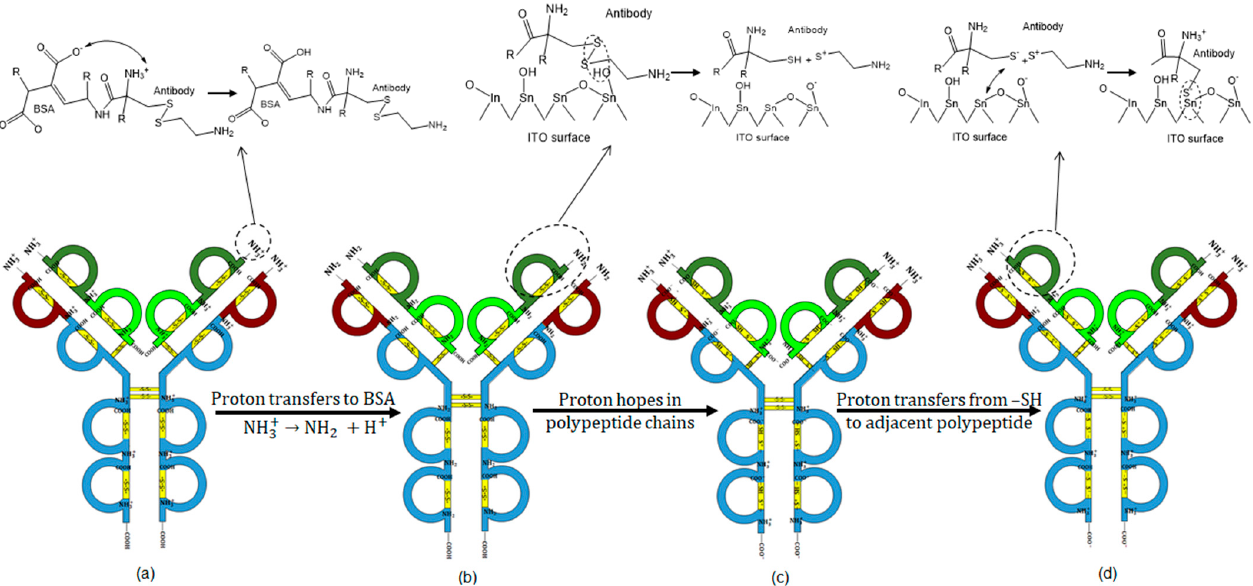
Figure 8. The charge transfer scheme in polypeptide chains in antibodies. ( a ) IgG antibodies with 16 disulfide bonds, the carboxylic groups at the C-terminal end, and the α -amino groups (NH + ) at the N-terminal end of the polypeptide. 3 ( b ) Due to conjugating antibodies with BSA molecules on the surface of the ITO, protons from NH + groups of a polypeptide 3 in the antibody migrate to BSA. Disulfide bonds also break and get reduced to R-SH and R’-S + bonds. ( c ) The protons from the C-terminal end of the polypeptide chain migrate through the amino acid sequences until they reach to the N-terminal end of the antibody. The antibody is polarized due to proton hopping in a polypeptide chain. ( d ) The protons transfer from the R-SH bonds to the adjacent polypeptide chains and the thiols change to thiolate anions (R-S − ). The R-S − on the antibody approaches the Sn on the ITO surface. The protons from the hydroxyl groups on the surface move to the thiolate anions in the antibody. This generates electrons on the surface that results in increasing the surface